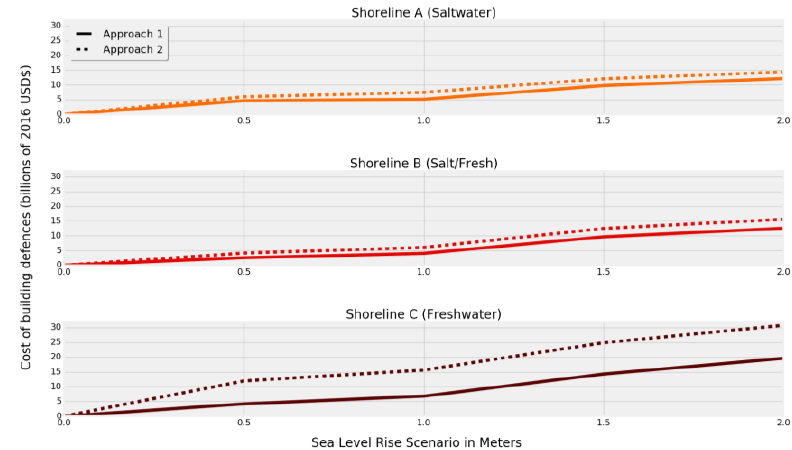
Figure 8. Figure comparing the impact of the land purchase costs across the three different shorelines—A, B, and C—in billions of 2016 USD$. Approach 1 (shown as a solid line) does not include land purchase costs, whereas Approach 2 (shown as a dashed line) includes a land purchase cost. Each subplot shows only the landform costs in billions of dollars.